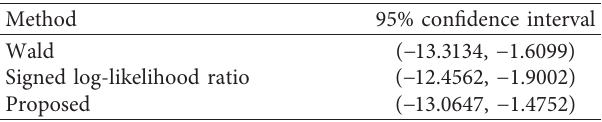
Table 2: 95% confidence intervals for the difference of the KS Sharpe ratios.